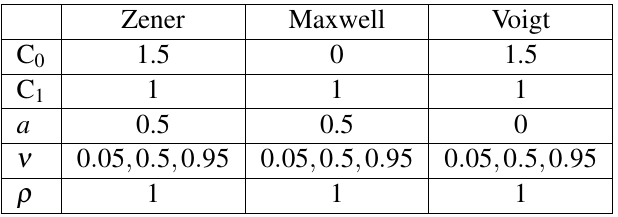
Table 2 The parameters used to create the plots given in Figure 3.